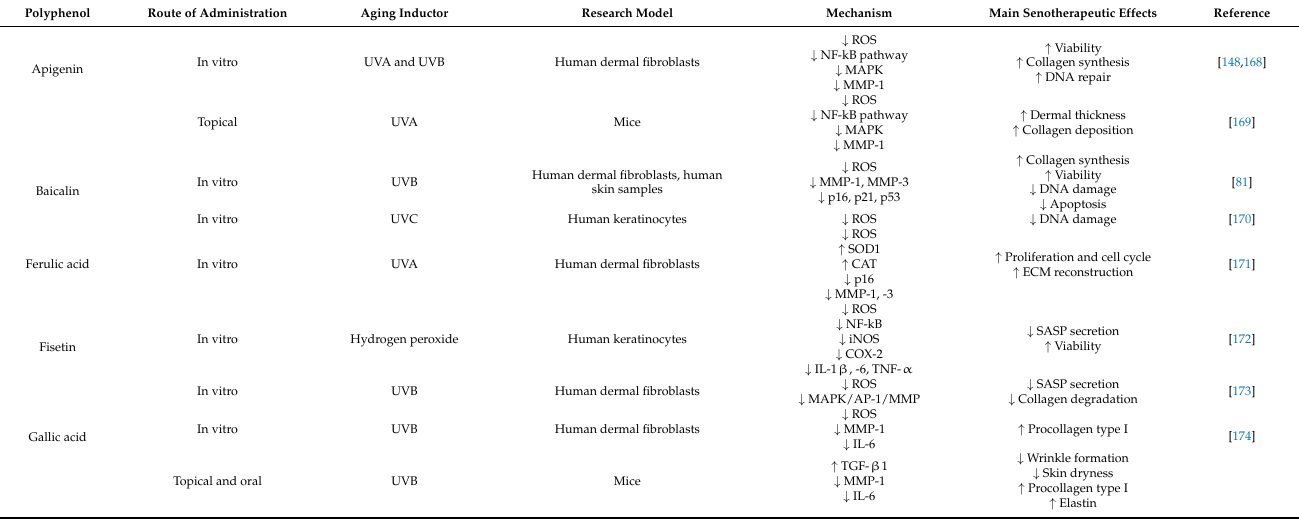
Table 3. Polyphenols with combined antioxidant capacity and skin senotherapeutic activity: the route of administration, research model used, aging inductor, and proposed mechanisms of